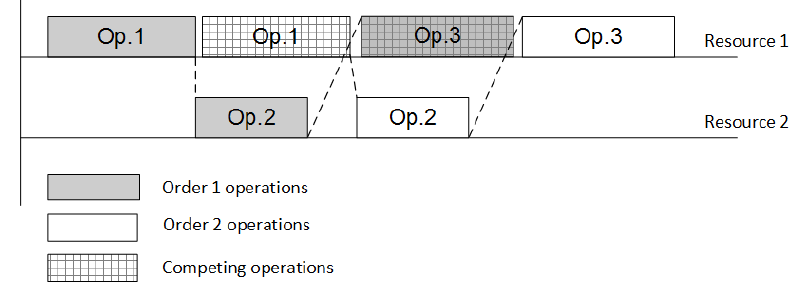
Figure 1. Competing operations on one